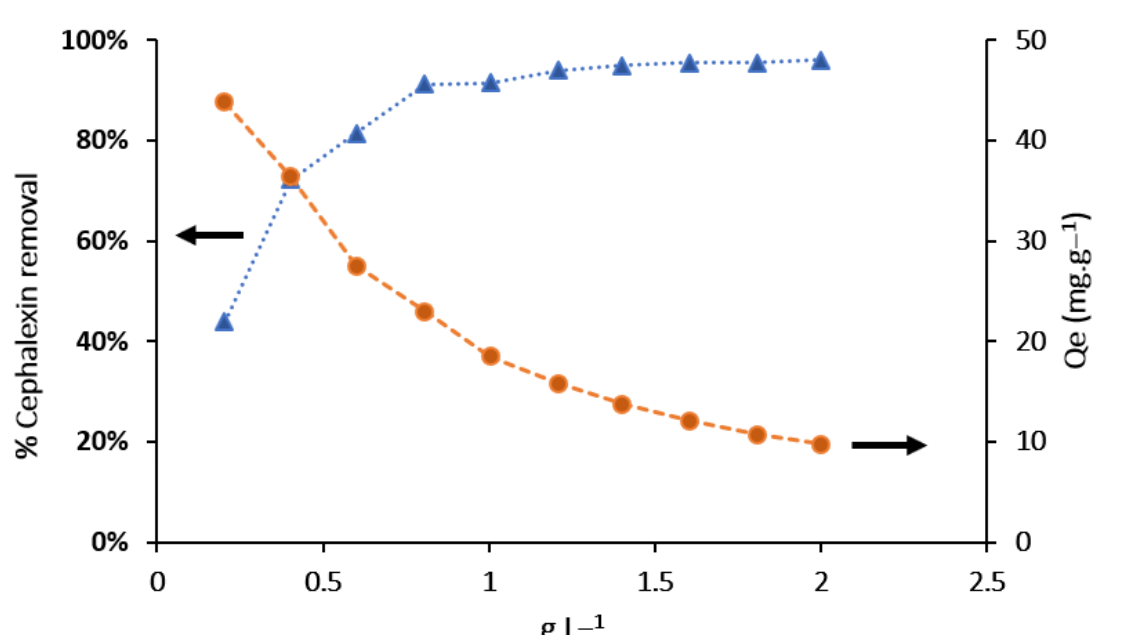
Figure 5. Effect of adsorbent dosage on the adsorption capacity and percentage removal of CPX (adsorption conditions: (CFX): 20 mg·L − 1 , time: 180 min).